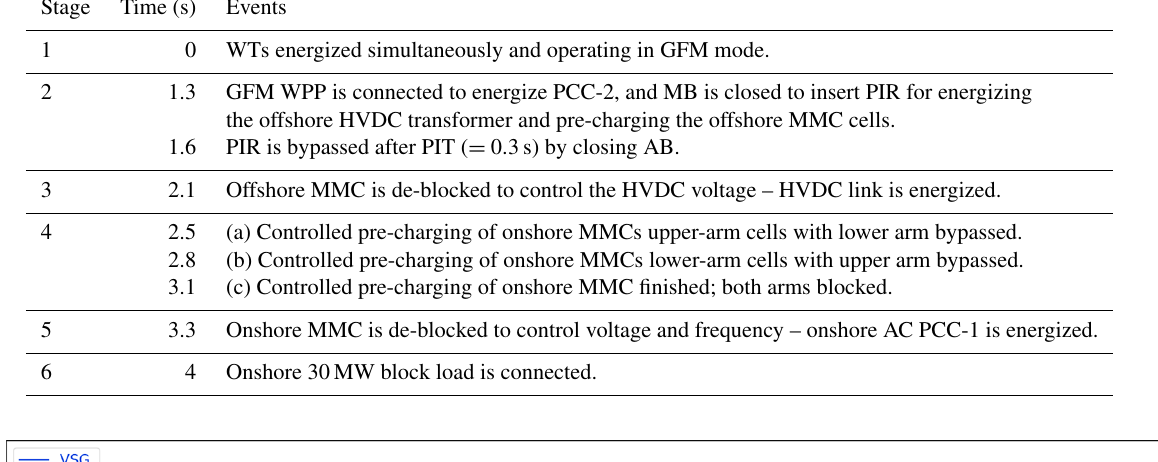
Table 1. Simulation events of the energization sequence.